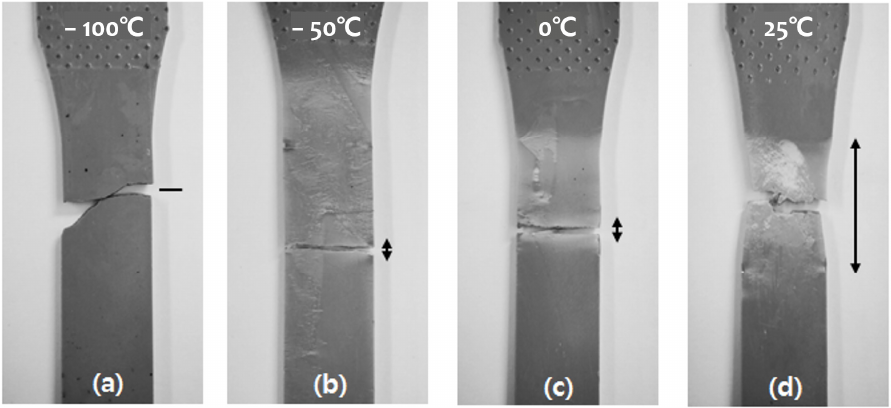
Figure 5. Failure types of the PE specimens depending on temperatures: ( a ) − 100 °C, ( b ) − 50 °C, ( c ) 0 °C, and ( d ) 25 °C.